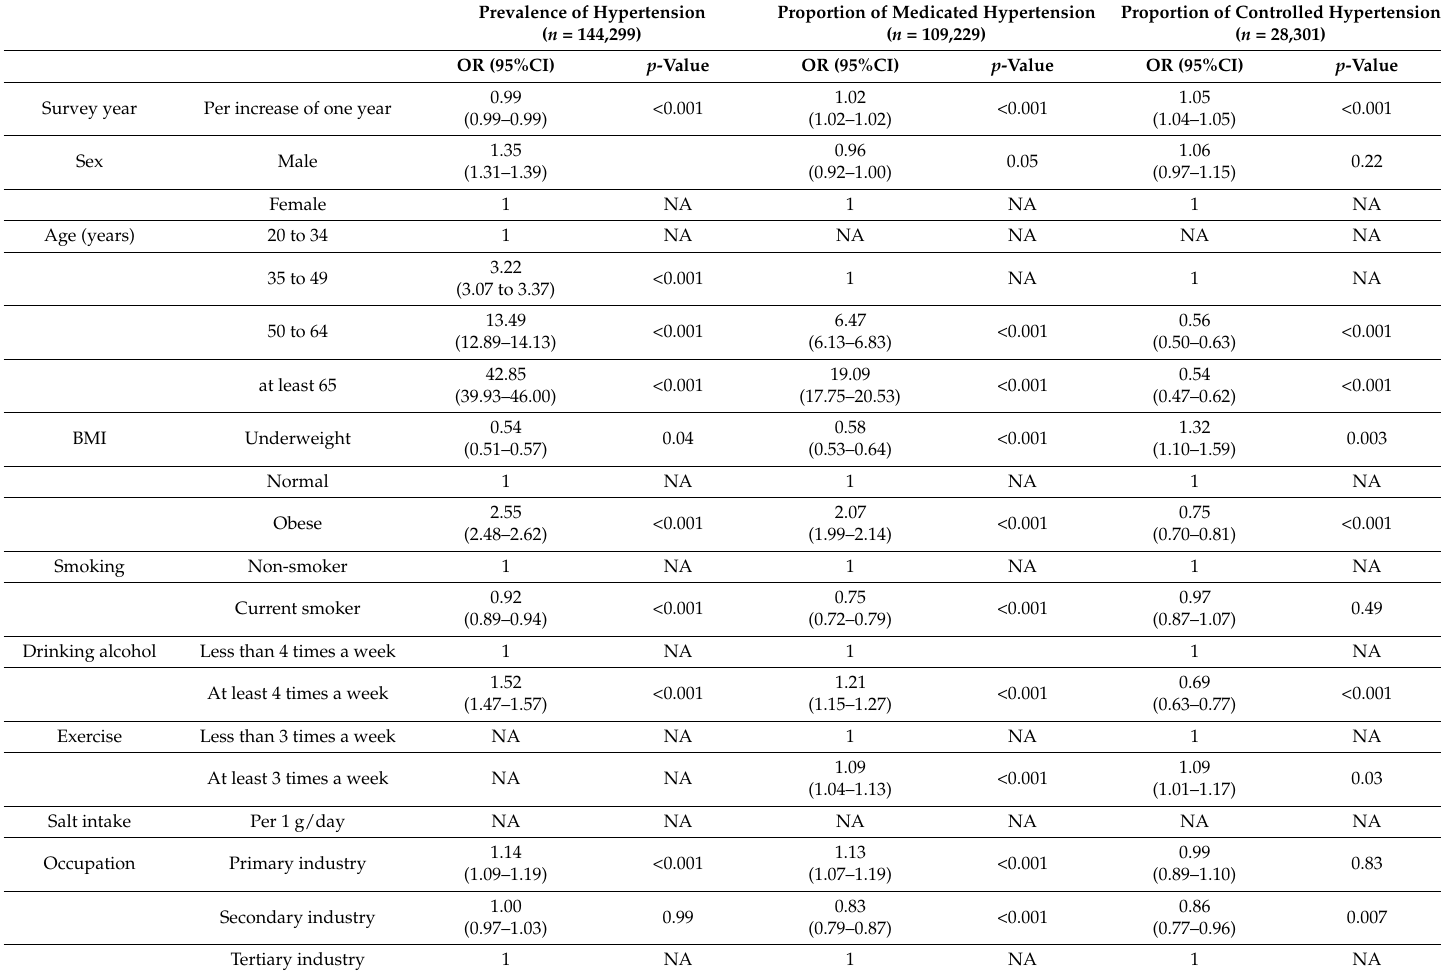
Table 4. The adjusted odds ratios for the prevalence of hypertension and the proportion of medicated and controlled hypertension for the survey years 1986 to